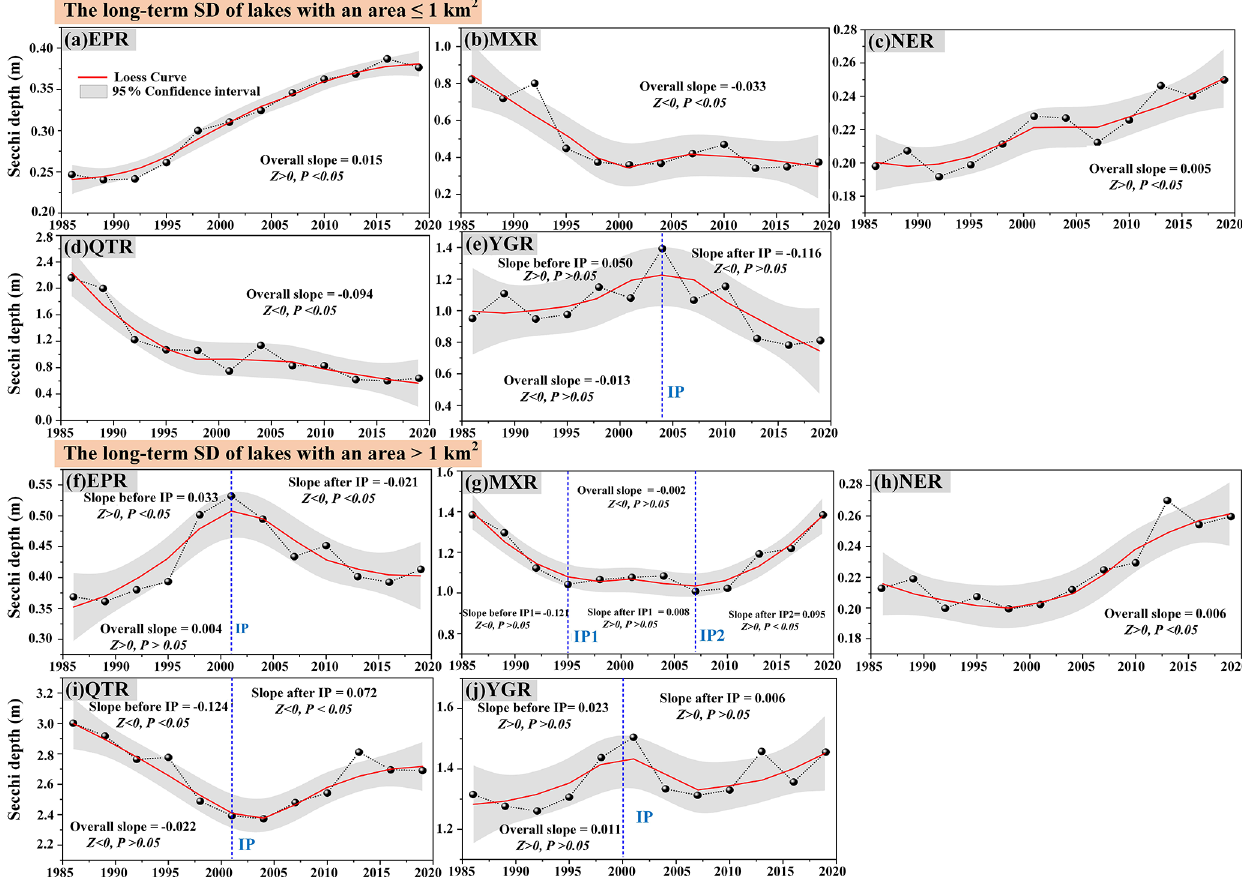
Figure 10. The long-term SD trend of lakes in each limnetic region from 1985 to 2020. (a–e) The long-term SD trend of lakes with an area ≤ 1km 2 in each region and (f–j) the long-term SD trend of lakes with an area > 1km 2 in each region. Note: EPR – Eastern Plain Region, MXR – Mongolian–Xinjiang Plateau Region, NER – Northeast Mountain Plain Region, QTR – Qinghai–Tibet Plateau Region, YGR – Yunnan–Guizhou Plateau Region, and IP – inflection